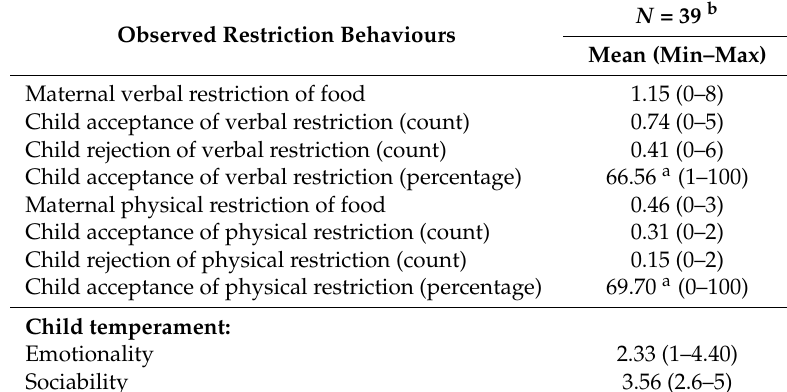
Table 1. Descriptive statistics for observed restriction and child temperament at 3–5 years